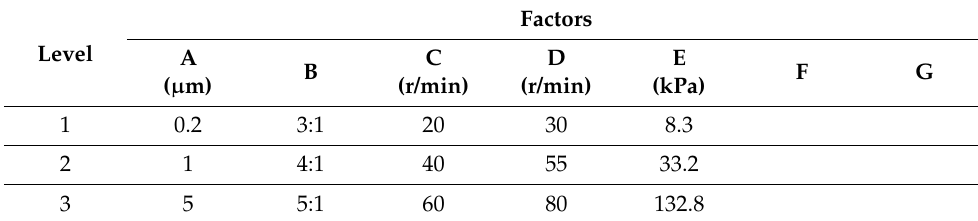
Table 1. Designed orthogonal table.